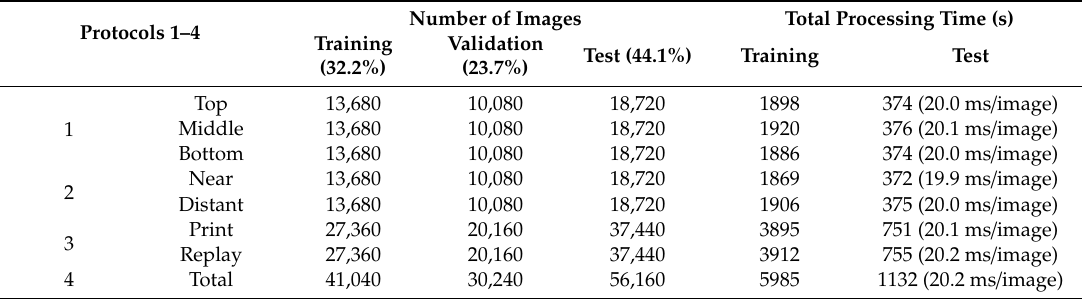
Table 3. Data composition and processing time for the experiment.